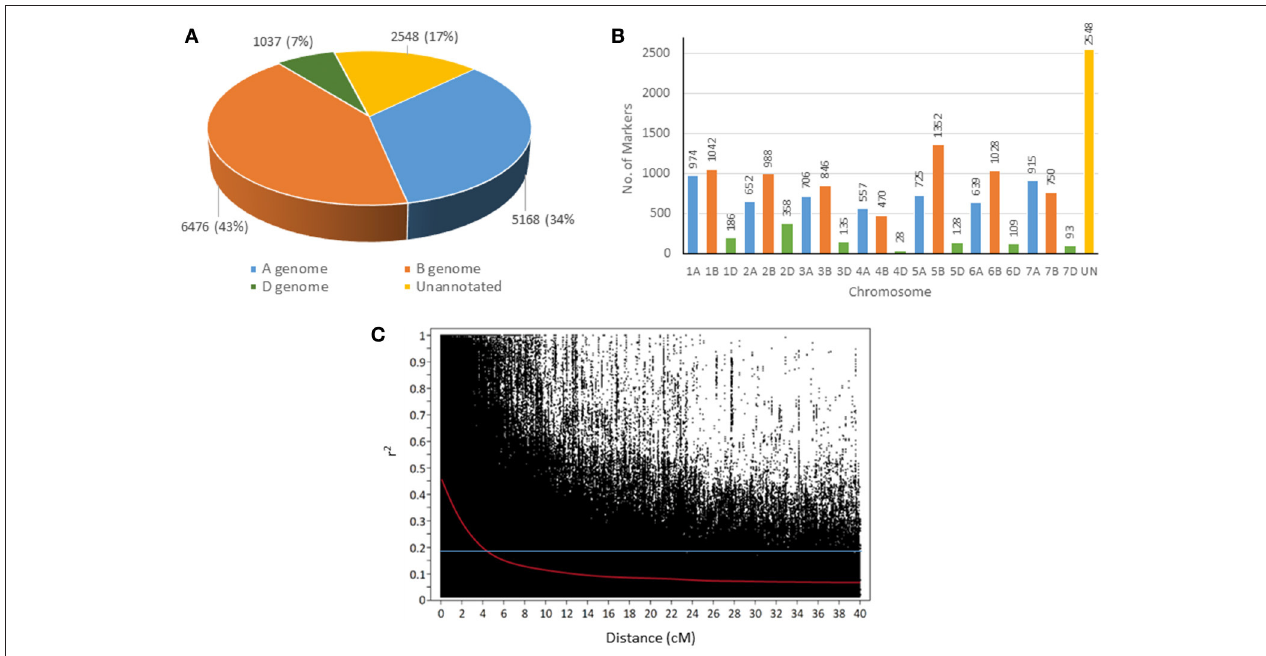
FIGURE 2 | Distribution of 15,229 SNP markers across the genome (A) and different chromosomes (B) . A scatterplot (C) showing the decline of genome-wide linkage disequilibrium (LD) r 2 over genetic distances (cM). The horizontal line corresponds to the 95th percentile of distributions of unlinked ( > 40cM) markers at r 2 = 0.18.